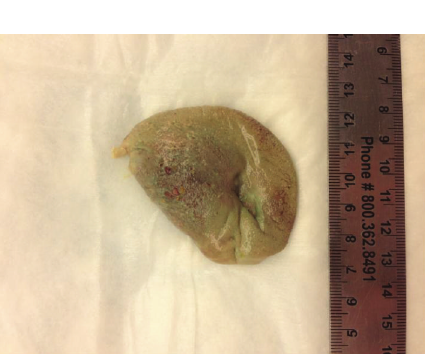
Figure 2: Necrotic appearance of the tongue posterior to dislodge- ment.